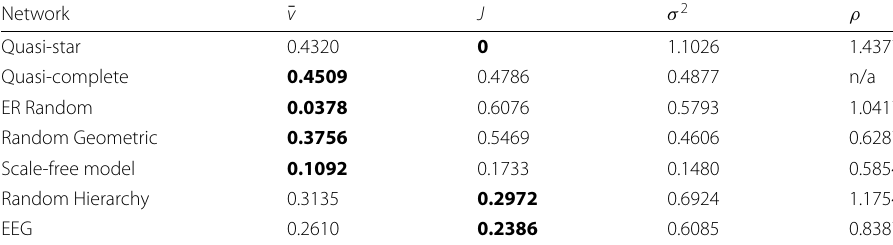
Table 4 Coefficient of variation of network indices with respect to density, averaged over network size Network ¯ v J σ 2 ρ Quasi-star 0.4320 0 1.1026 1.4377 Quasi-complete 0.4509 0.4786 n/a ER Random 0.0378 Random Geometric 0.3756 Scale-free model Random Hierarchy EEG Boldface indicates the best result among the